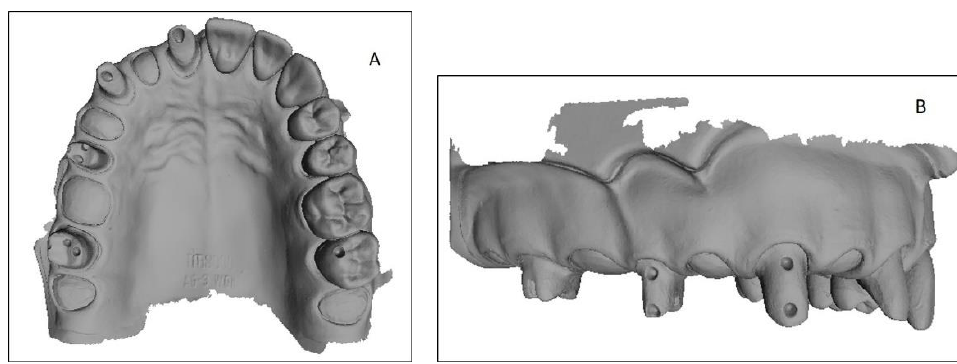
Figure 3. ( A , B ). Scanned images of prepared typodont master model.